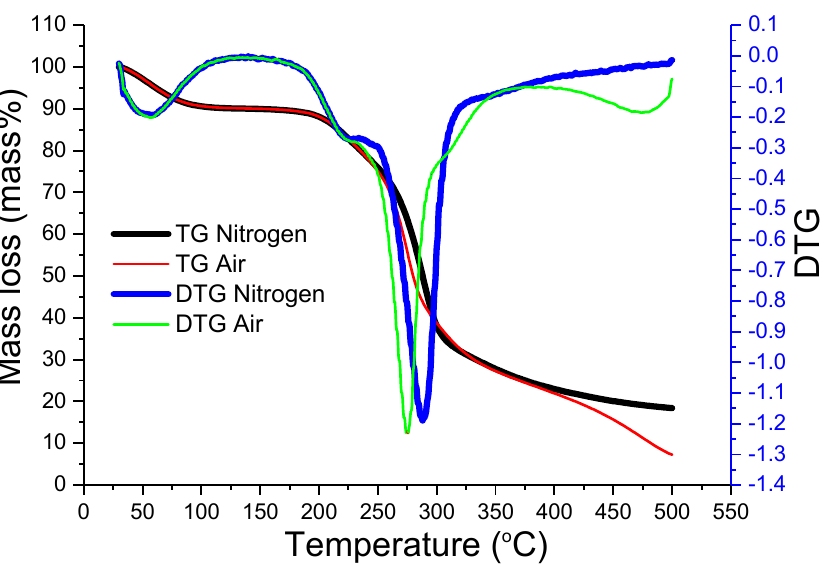
Figure 4. Thermogravimetry (TGA) and differential thermogravimetric (DTG) curves of the T. fuciformis polysaccharides obtained from freeze-drying in nitrogen and air atmospheres, respectively, at the selected heating rate of 6 °C/min (the complete analysis results were obtained with multiple heating rates of 6, 8, and 10 °C/min).